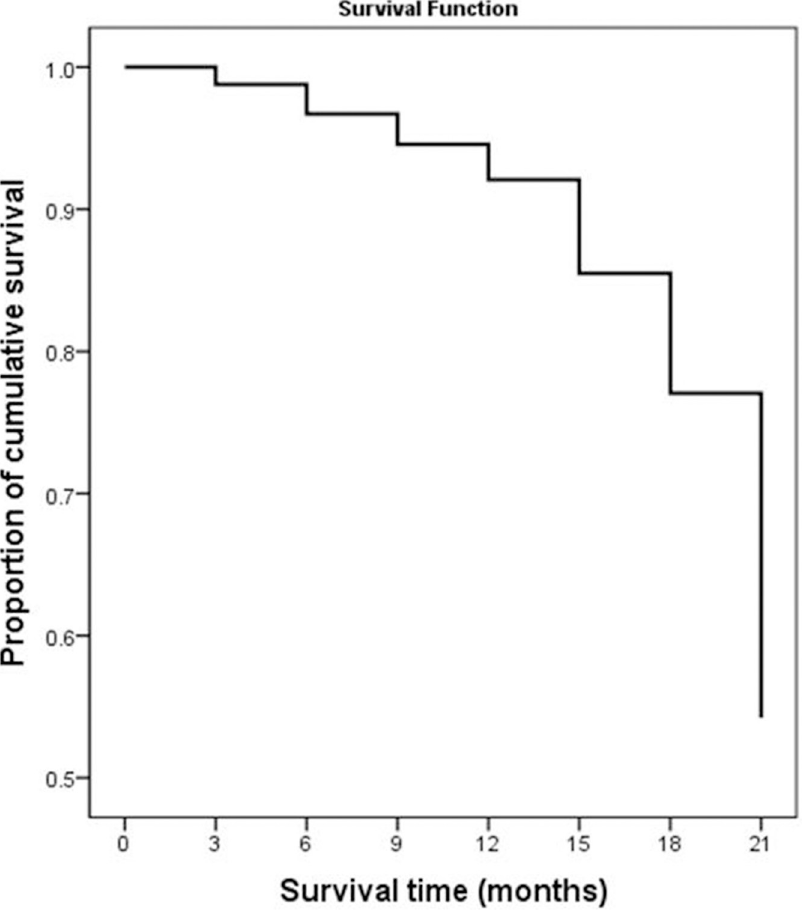
Fig 1. 21-month cumulative survival rate of tuberculosis patients in